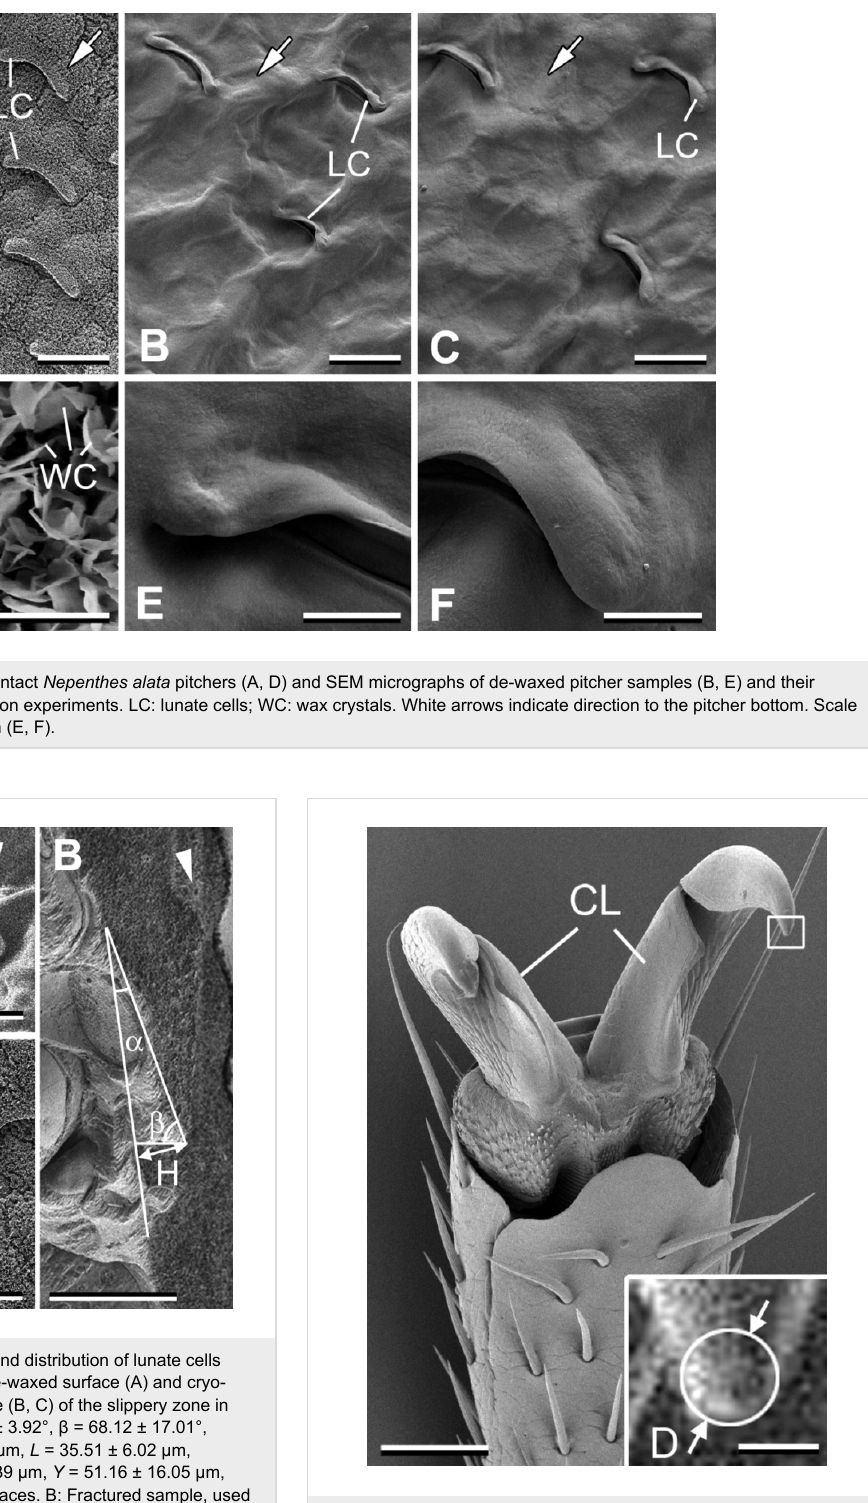
Figure 3: SEM micrographs of the distal part of the tarsus in the Coccinella septempunctata beetle. Inset shows magnified claw tip, where the white inscribed circle was used to measure the diameter of the claw tip. CL: claws; D: diameter of the claw tip. Scale bar = 50 μ m. Scale bar of the inset = 5 μ